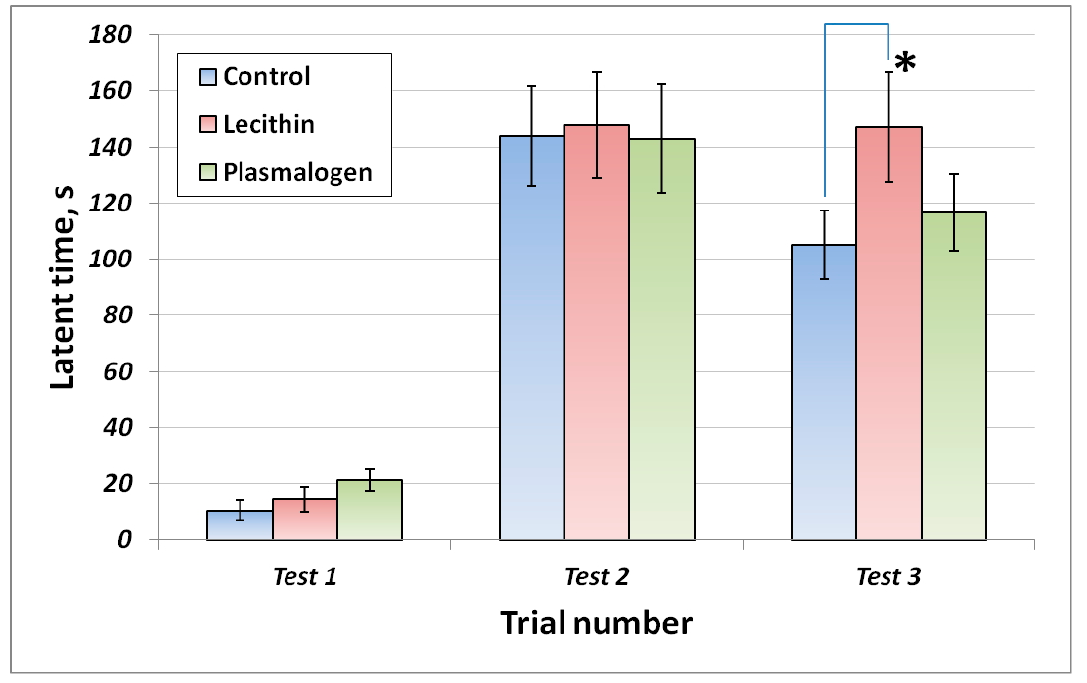
Figure 4. Passive avoidance test results. Values are mean ± SEM of 15 rats per group Test 1 was conducted on day 11 Test 2 is the short-term memory test conducted on day 12 Test 3 is the long-term memory test conducted on day 33 * one-way ANOVA p < 0.05 versus Control.